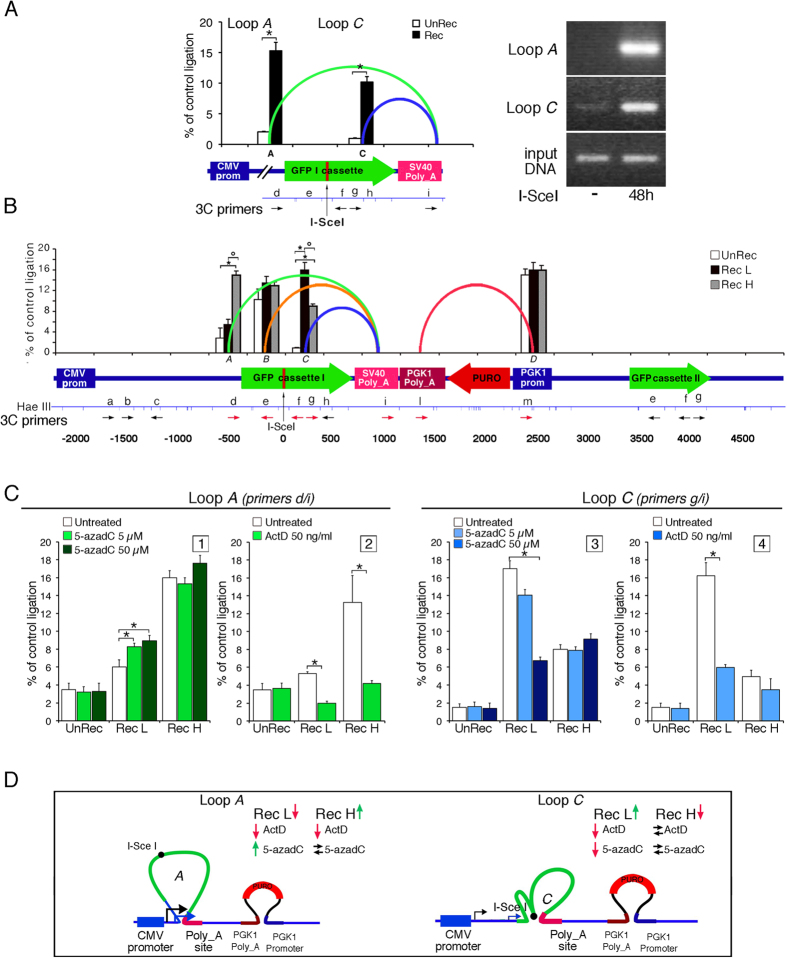
Chromatin-DNA domains induced by damage-repair.(A) Left. GFP chromatin loops in recombinant (Rec, black) and unrecombinant (UnRec, white) cells 7 days after DSB. qPCR in 3C, performed with the primers indicated (HaeIII map), show the frequency of ligation (mean ± SD) of the DRGFP HaeIII fragments amplified with the specific primers. The ends of the loops are shown by the green (loop A) and blue (loop C) lines, corresponding to the regions indicated by arrows and boxes. Ligation efficiency is relative to the DRGFP plasmid digested with HaeIII, ligated and amplified by qPCR. Distance, in bp, is relative to I-SceI site (vertical arrow), *p < 0.01 (t test) Rec vs UnRec. Right. A representative gel of the ligated fragments (loops A and C) in cells exposed or not for 48 h to I-SceI. (B) GFP loops in Rec H and Rec L cells. The 5′ end of the loop A (green) includes an alternative GFP transcription start site, identified by primer d. Differences between non-recombinant, H or L cells *p < 0.01 (t test); °p < 0.01 (t test) H vs L cells. (C) Inhibition of methylation (panels 1, 3) or transcription (panels 2, 4) alters the chromatin loops induced by HR. Panels 1 and 3. Sorted GFP− (UnRec) or Rec H or Rec L cells were exposed to 5 or 50 μM 5-azadC for 24 h + 24 h in standard medium. Loops A and C were monitored as described above. The results derive from at least 3 experiments in triplicate. *p < 0.01 as compared to untreated samples (Wilcoxon rank-sum test). Panels 2 and 4. Sorted GFP− (UnRec) or Rec H or Rec L cells were exposed to 5 μM actinomycin D for 24 h, washed and analysed 48 h later. *p < 0.01 (Wilcoxon rank-sum test) compared to untreated cells. (D) Model summarizing the features of Loops A and C. The red and green arrows indicate decrease or increase of loop formation, respectively, while the black arrows indicate no change. The two GFP transcription start sites are indicated by black and blue arrows.